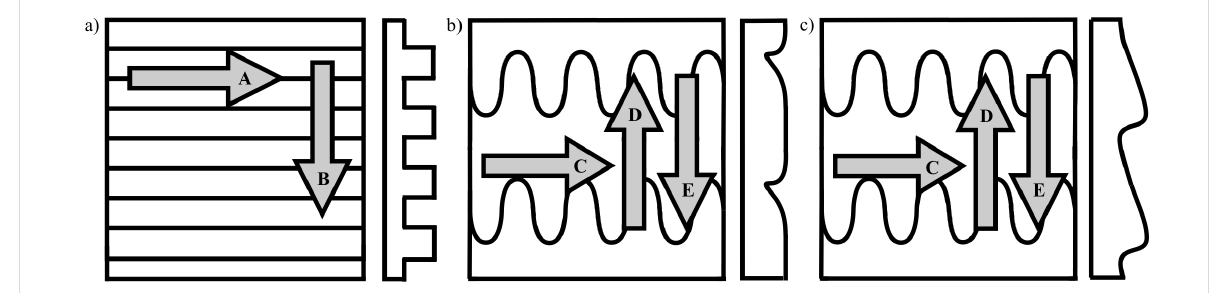
Figure 8: Scheme of surface geometry and sliding directions of friction measurement, top view (left) and side view (right). a) Periodical groove-like polymer surface - PGMS, b) Polymeric mould of L. g. californiae – PMLG, c) Snake-inspired microstructured polymer surface – SIMPS. Directions of measurement: A: parallel to microstructure, B: perpendicular to microstructure, C: lateral to microstructure, D: against microstructure, E: along micro- structure.